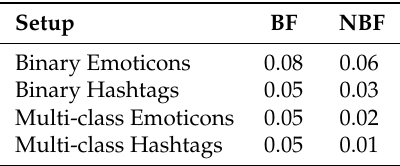
Table 3. Fraction of tweets with no matching vectors (BF for Bloom filter and NBF for no Bloom